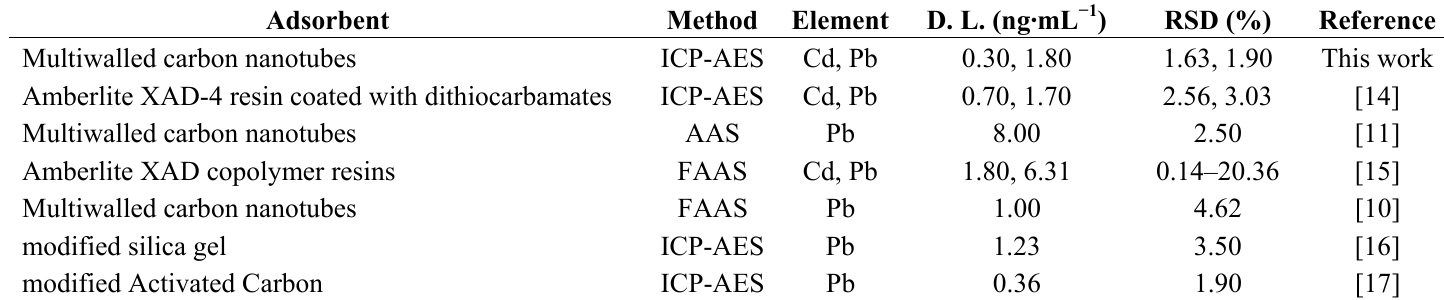
Table 7. Comparative data of the analytical performance with those in the literature.